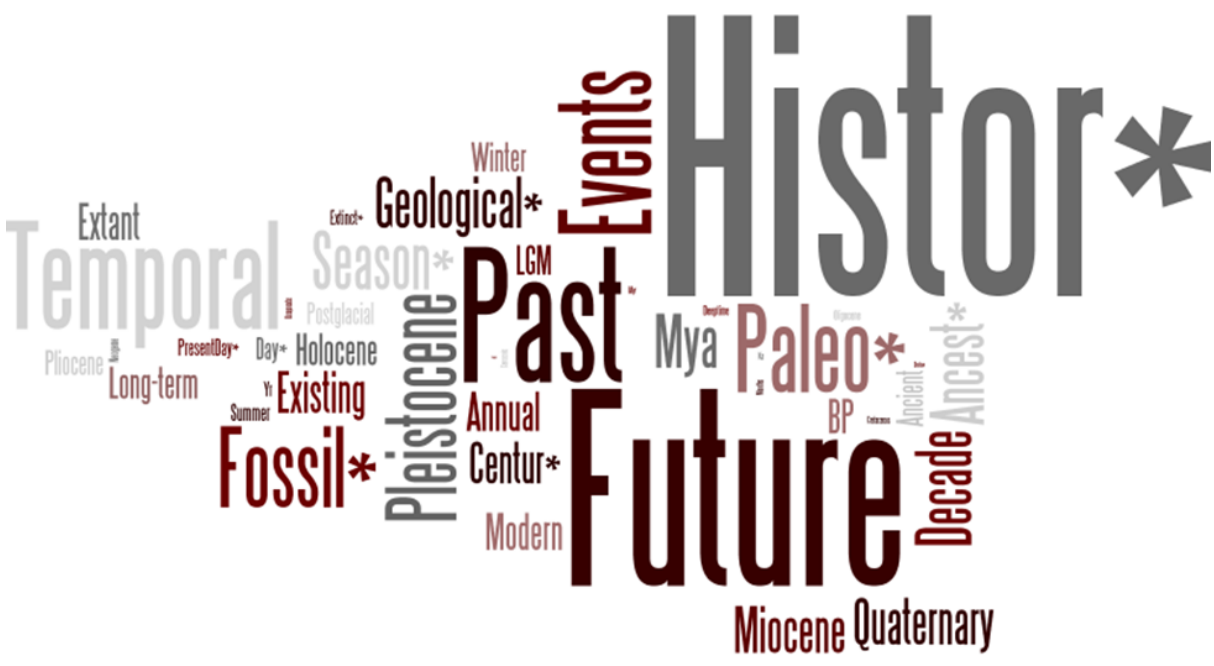
Figure 4. Terms related to time that appeared commonly in abstracts submitted for the 7 th IBS biennial meeting. Analysis as described in the caption to Figure 1; based on n = 820. Asterisks indicate the word also occurred in plural w or other form (e.g., “Histor*” represents the use of “history”, “historic”, and “historical”). The most common term (“Histor*”) in the analysis occurred in 114 abstracts; the least common term in the analysis occurred twice. The ratio of terms relating to Pleistocene and earlier times versus Holocene and later times (excluding the “future”) is approxi- mately